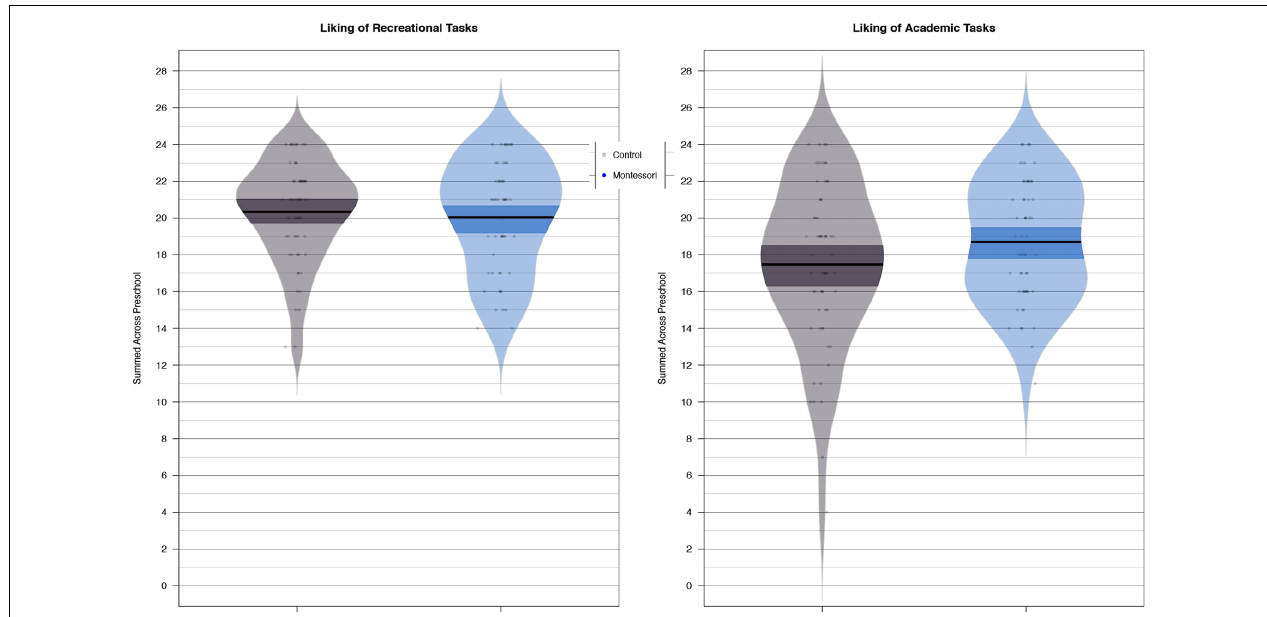
FIGURE 3 | Enjoyment of recreational (left panel) and academic (right panel) activities across preschool. Montessori children ( n = 55, blue beans, on right side of each panel) were relatively more favorable to academic tasks than control children ( n = 63, gray beans). Dots represent children, bars represent means, and shaded areas represent 95% confidence